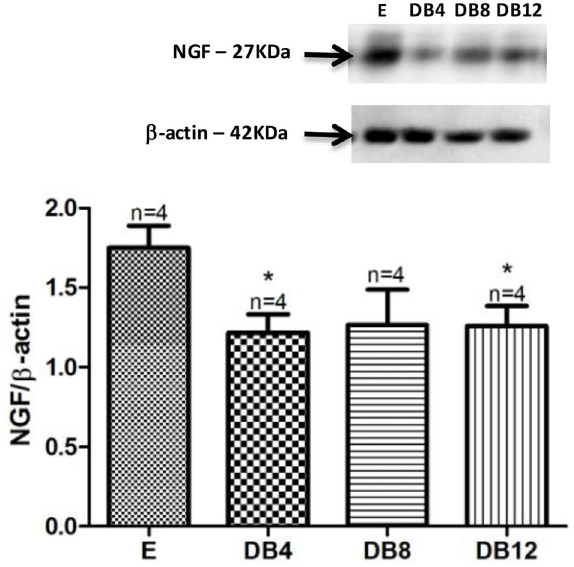
Figure 1. Nerve growth factor (NGF) protein expression in rats with 4, 8, and 12 weeks in diabetic state (DB4, DB8, and DB12, respectively) compared to euglycemic rats (E). b -actin was used as loading control. Data are reported as means ± SE. *P o 0.05 vs E group (Student ’ s t -test).